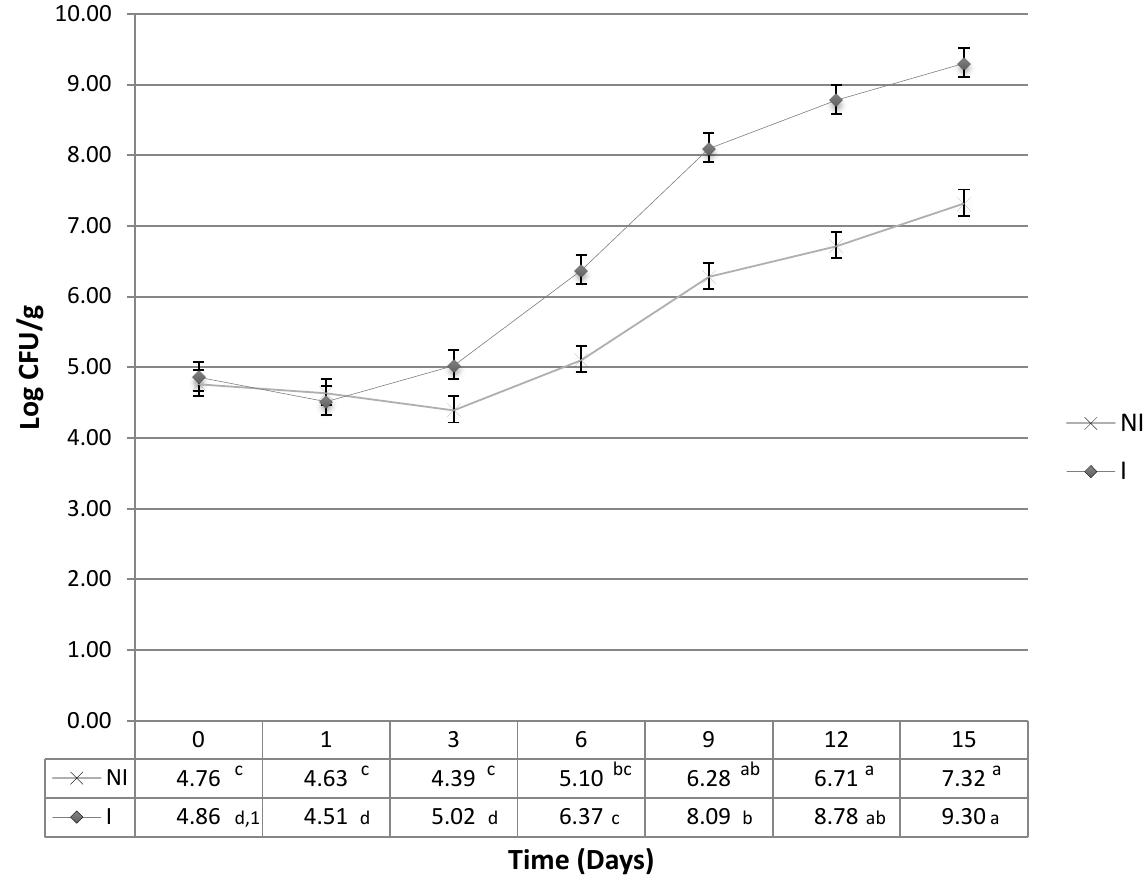
Figure 1. Average growth (Log CFU/g) of three trials of L. monocytogenes in 10 non-irradiated (NI) samples that contain the native micro-flora and irradiated (I) samples, at 10 °C ( n = 4/sample day). Common letter designation between and amongst groups indicate no significant difference ( p >